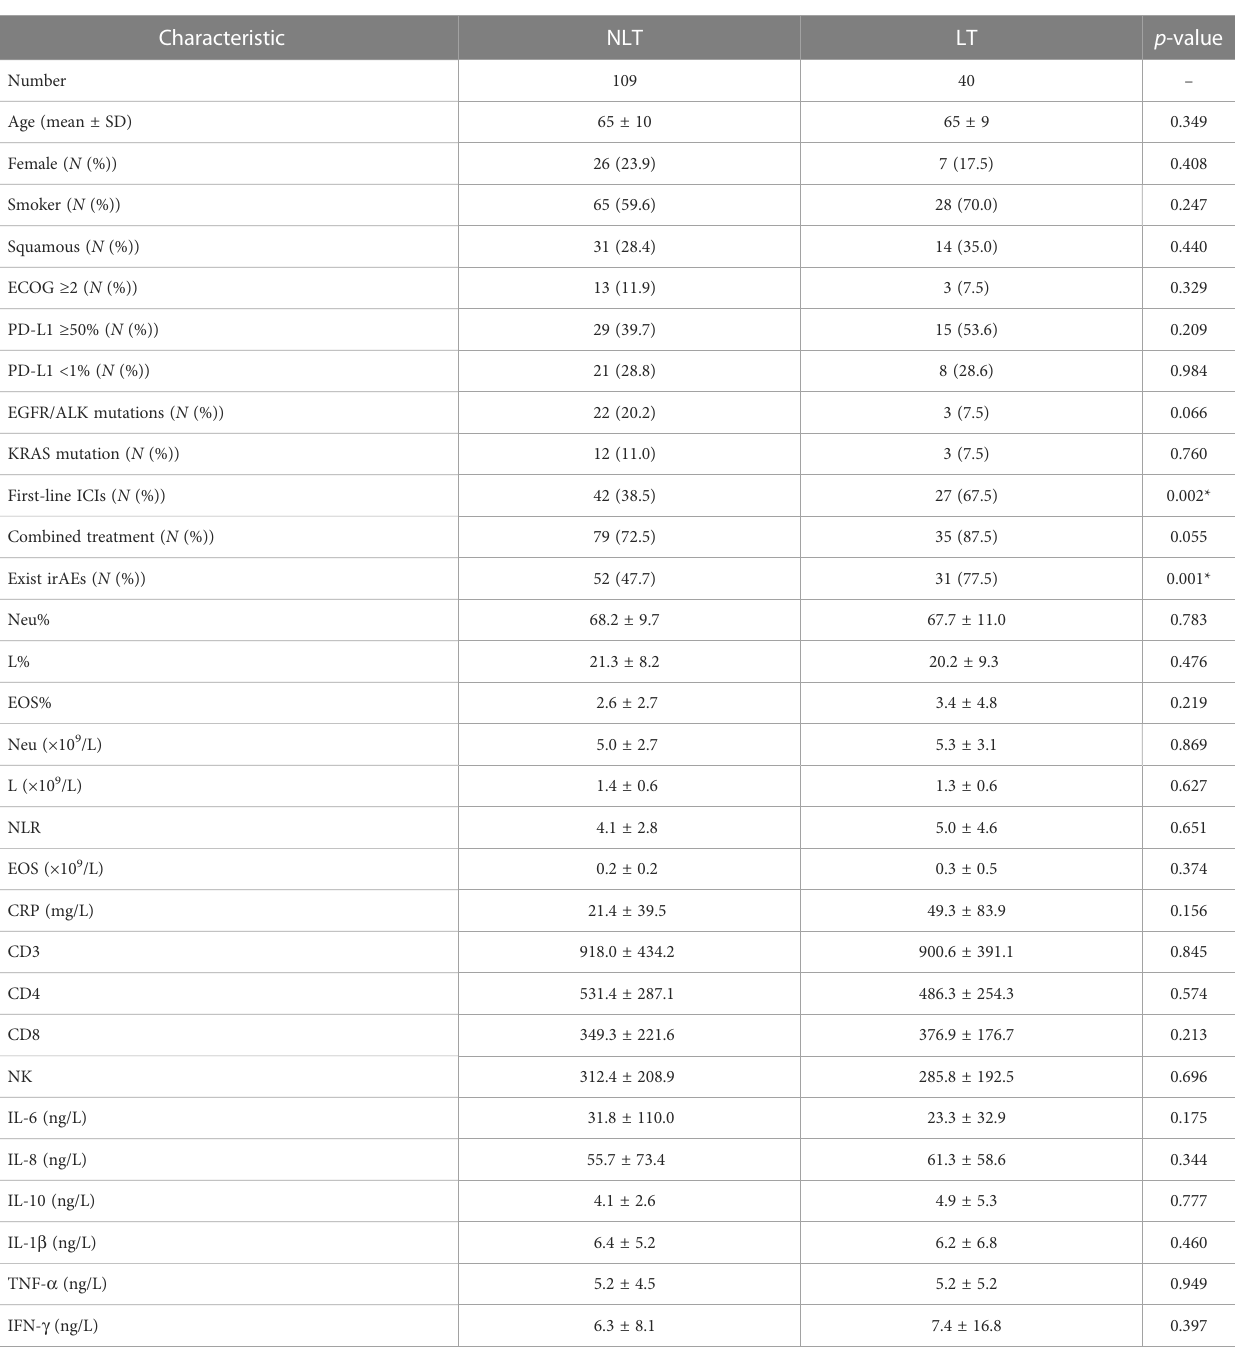
TABLE 2 Characteristics of patients with NLT or